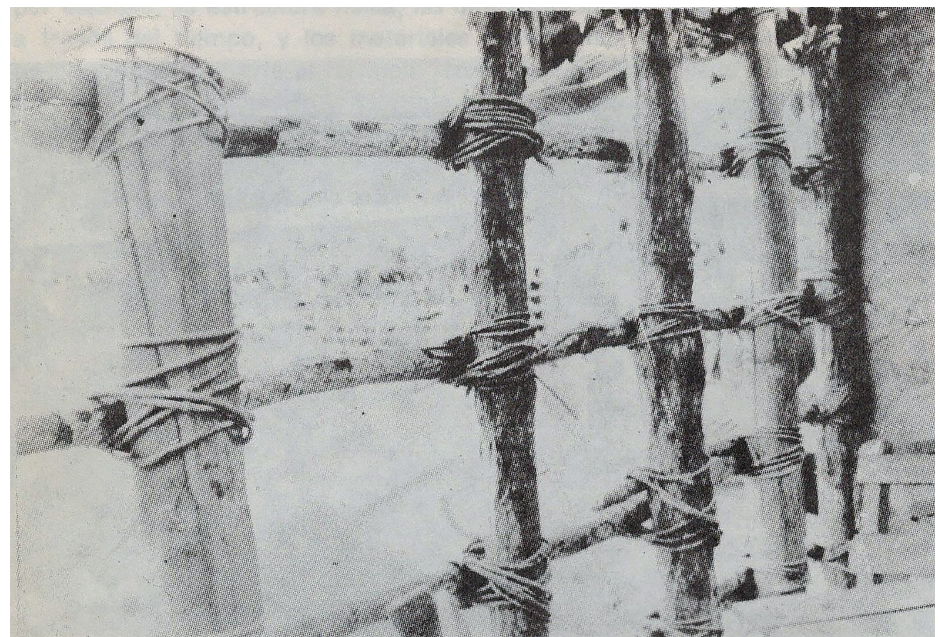
Figure 8. Image on the manual ability to solve, through braiding ( bejuco ), the union between natural elements. Source: Santana Vega J.A. (1986) in “El Mundo de La Corraleja”, editorial Graficas Corsa of Monteria, page 58 [9].